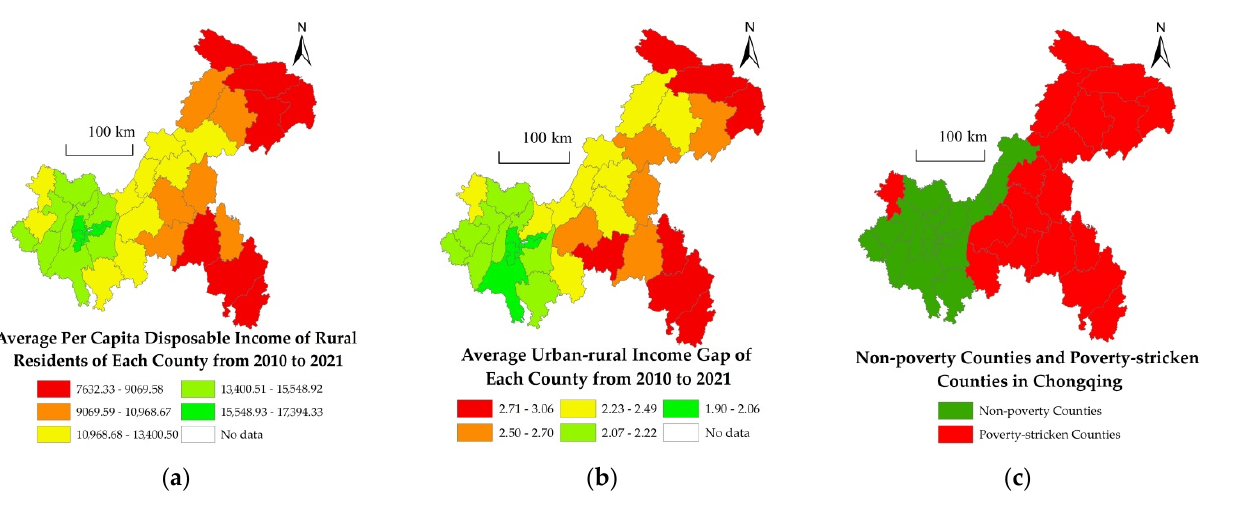
Figure 3. Spatial pattern analysis. ( a ) Spatial distribution of the per capita disposable income of rural residents in 37 counties of Chongqing; ( b ) spatial distribution of the urban–rural income ratio in 37 counties of Chongqing; ( c ) spatial distribution of poverty-stricken and non-poverty-stricken counties in Chongqing.